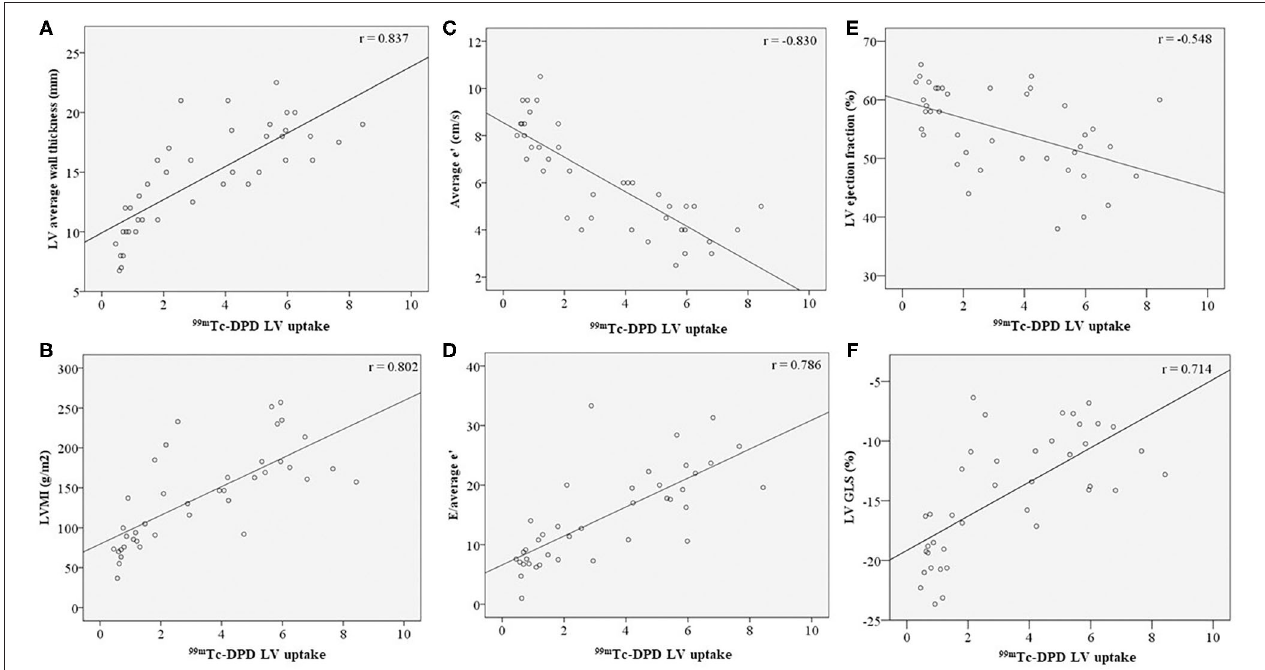
FIGURE 3 | Correlation of LV structural and functional parameters with 99m Tc-DPD uptake. 99m Tc-DPD LV uptake correlation with (A) LV average wall thickness, (B) LVMI, (C) Average e’, (D) E/average e’, (E) LV ejection fraction and (F) LV GLS. Line of best fit plotted on all graphs. 99m Tc-DPD, Technetium-99m